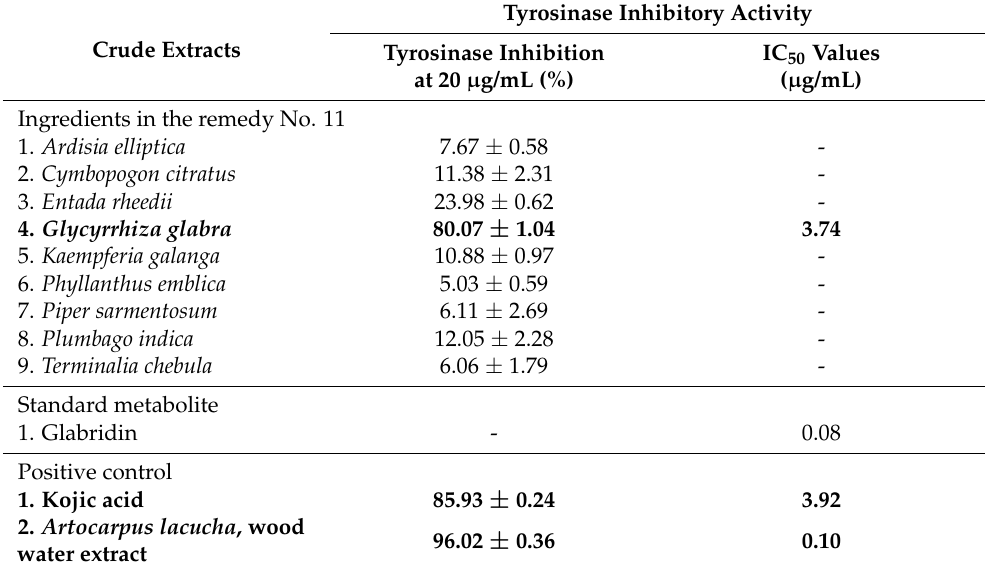
Table 2. Anti-mushroom tyrosinase activity of the remedy ingredients crude extracts at 20 µ g/mL